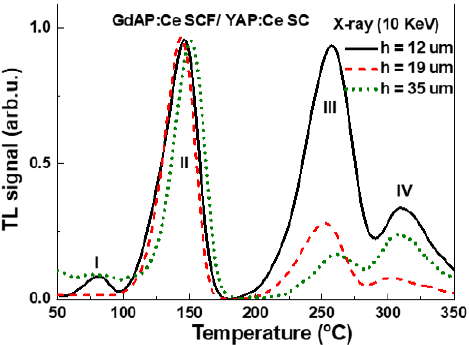
Figure 7. TL glow curves of GdAP:Ce SCF/YAP:Ce SC epitaxial structure under excitation by X-rays (the average energy being 10 keV).